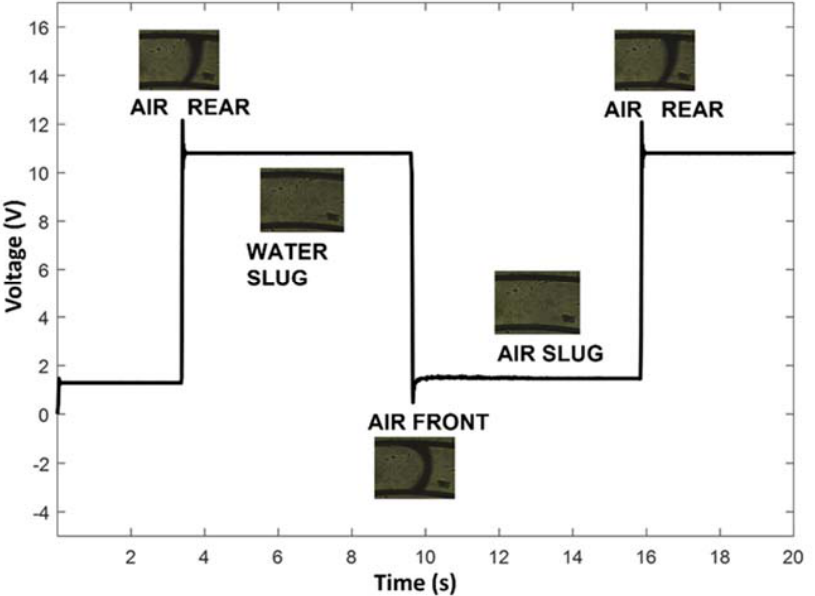
Figure 8. Optical signal acquired in the PDMS mofd correlated to the FLOW 1 passage in the EXP2 conditions (flow rate 0.1 mL/min).